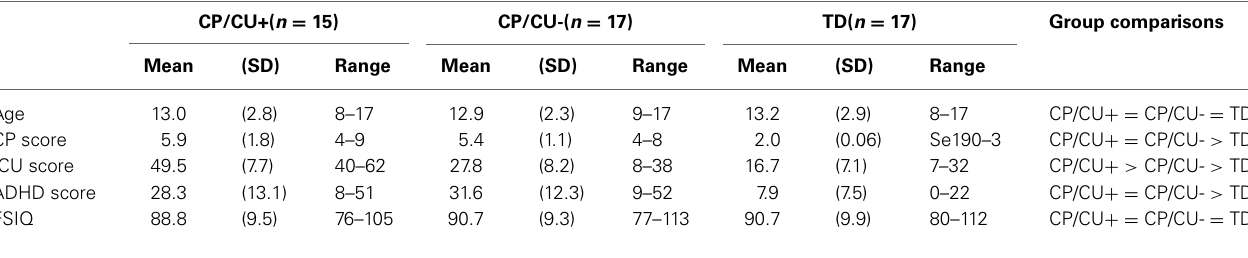
Table 1 | Means, standard deviations and ranges of age, IQ, conduct problems, CU traits and ADHD symptoms of each